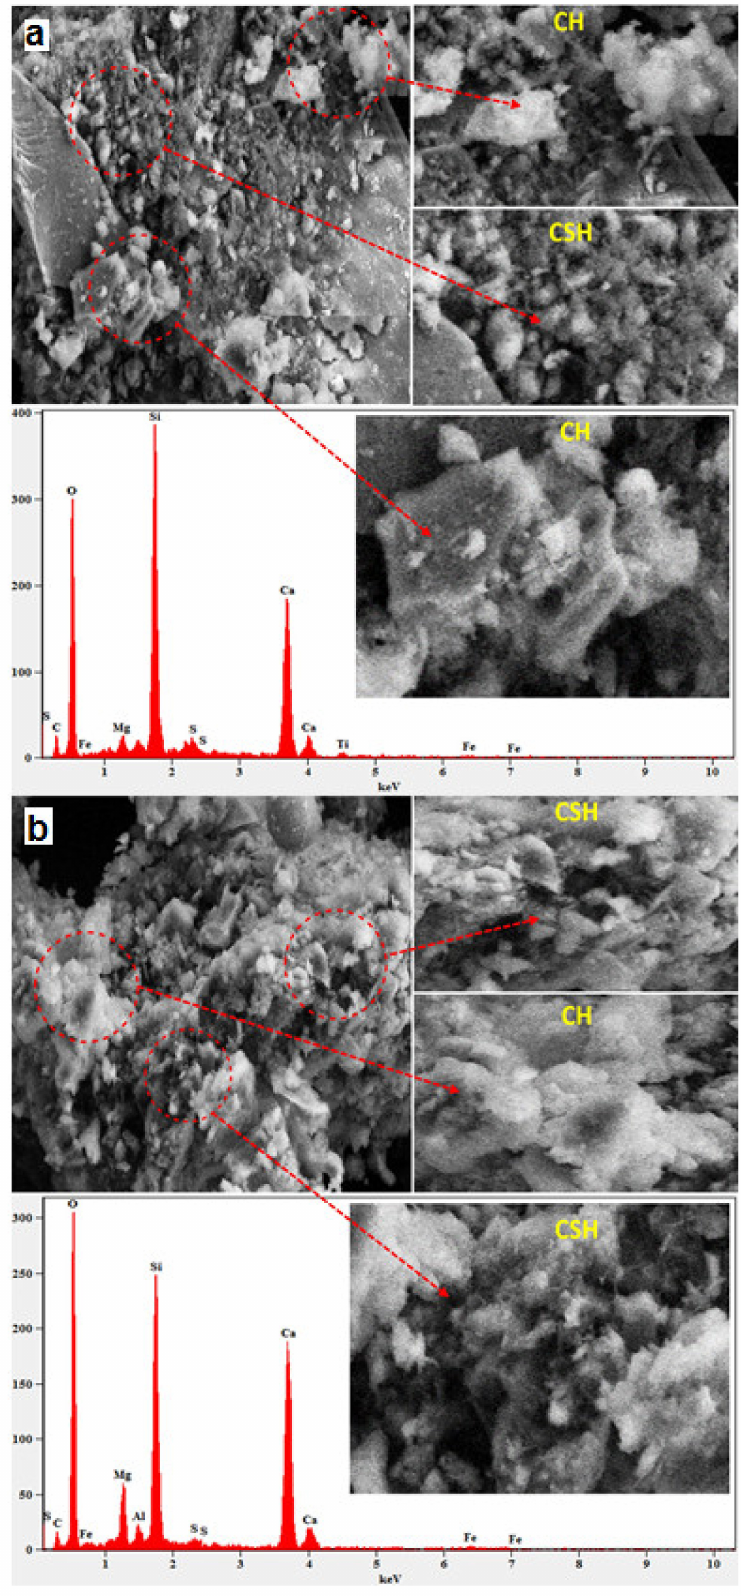
Figure 15. SEM and EDX result of LSR mortar. ( a ) 7 days and ( b ) 28